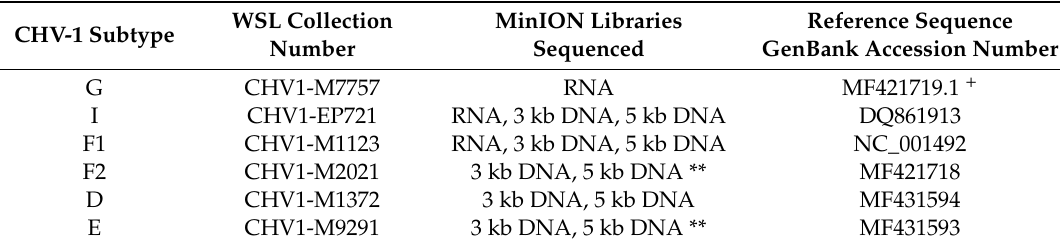
Table 1. The CHV-1 subtypes sequenced as DNA amplicons or directly as RNA. Subtypes each have two IDs: their viral subtype and the WSL laboratory strain ID. Also shown is the accession number in GenBank for the reference sequences used for each